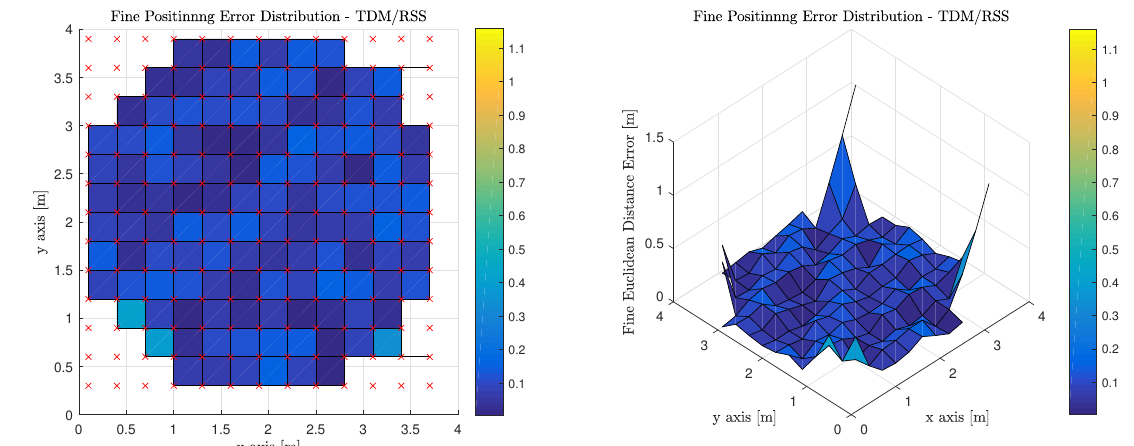
Figure 15. Fine Phase Positioning Performance in Candidate Room using Received Signal Strength Measurement, Least Squares Trilateration Positioning Algorithm and Time Division Multiplexing.